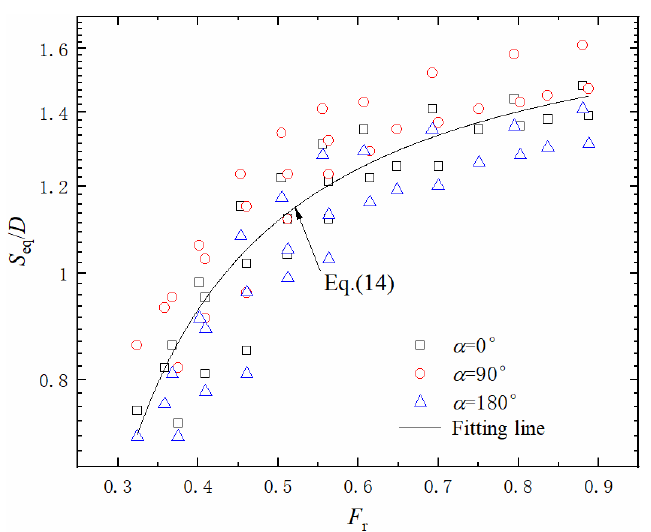
indicating the adaptation of the logarithmic formula (Equation (14) in Figure 9) to depict the correlation between S eq and F r for tripod.